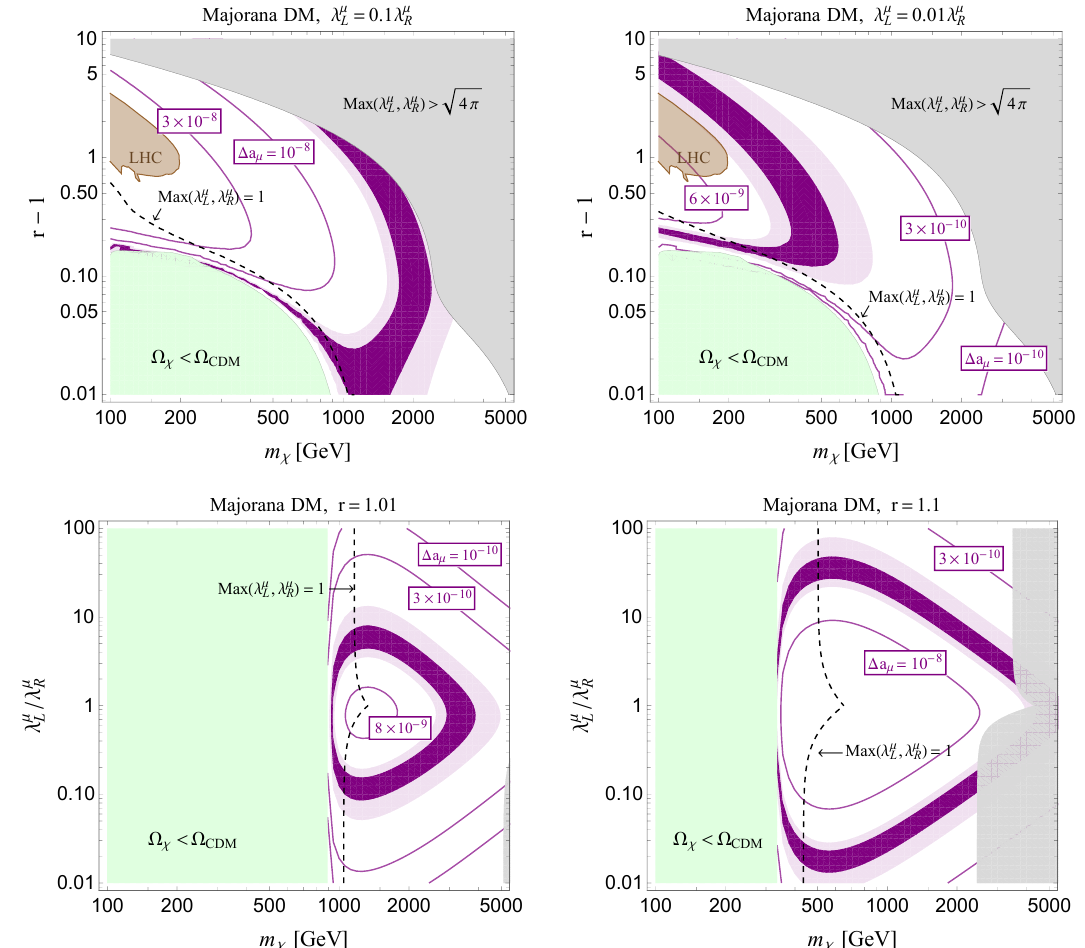
Figure 12 . The same plots for the Majorana DM as (cid:12)gure